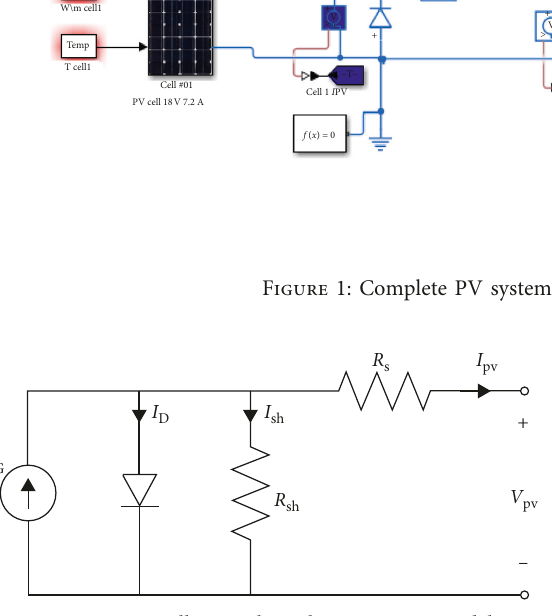
Figure 2: PV cell equivalent electric circuit model.